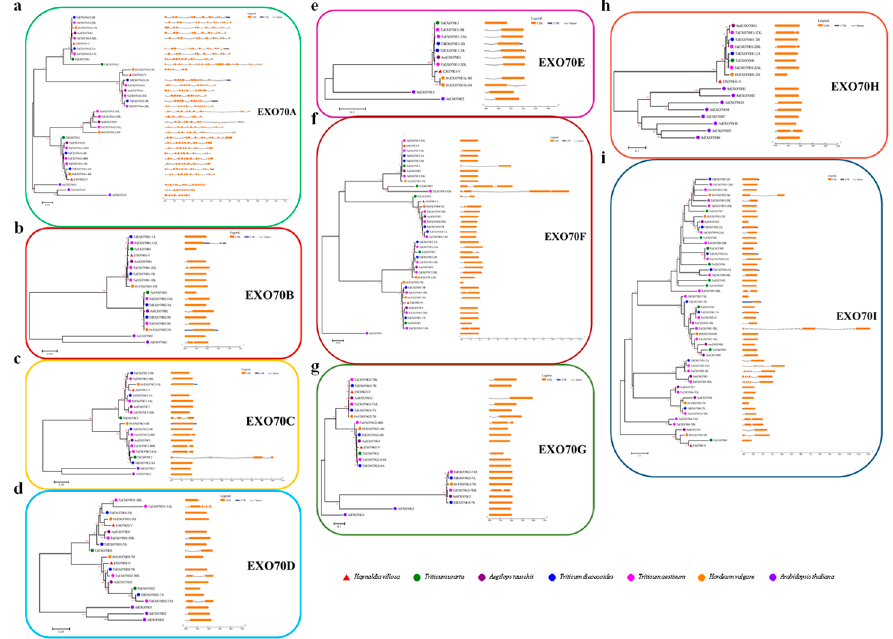
Figure 4. Phylogenetic analysis and exon–intron structures of EXO70 gene family in common wheat and related Triticeae species. The phylogenetic analysis was performed using the sequences of the conserved domain of EXO70 ; proteins were aligned by ClustalW, constructed by MEGA6 using the N-J method, with 1000 bootstrap replicates; the branch length scale bar indicates the evolutionary distance. The left column identifies subgroups and is marked with different alternating background tones to make subgroup identification easier. Introns and exons are represented by black lines and colored boxes, respectively.